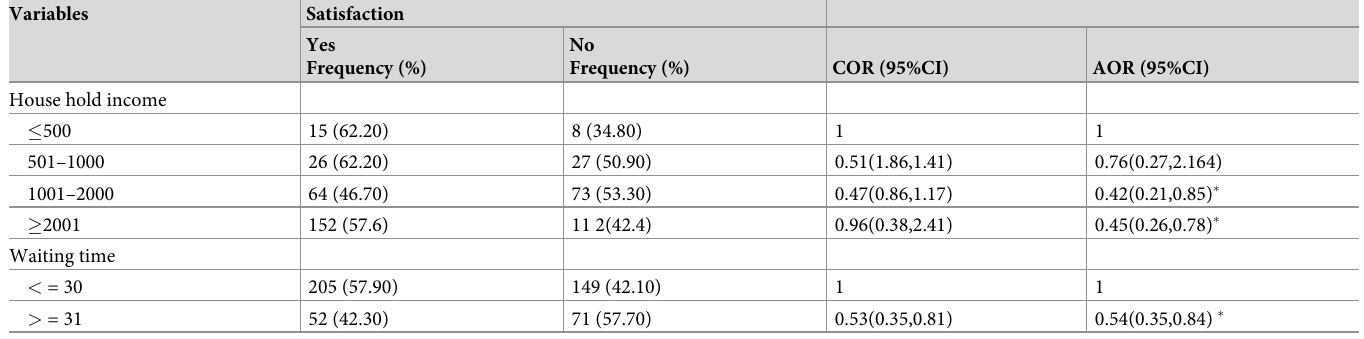
Table 6. Bi-variable and multi-variable logistic regression analysis result of clients’ satisfaction on service acceptability of family planning service in Gondar city public health facilities, Northwest Ethiopia, 2020. Variables